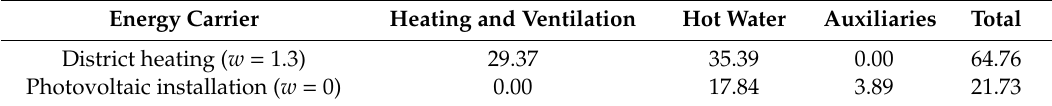
Table 22. The annual EK demand (kWh / (m 2 · year)) for the multi-family building at Akacjowa Street in Goleniow (district heating (Goleniow) + application of photovoltaic installation to supply auxiliary equipment and part of the energy for the preparation of the hot water).